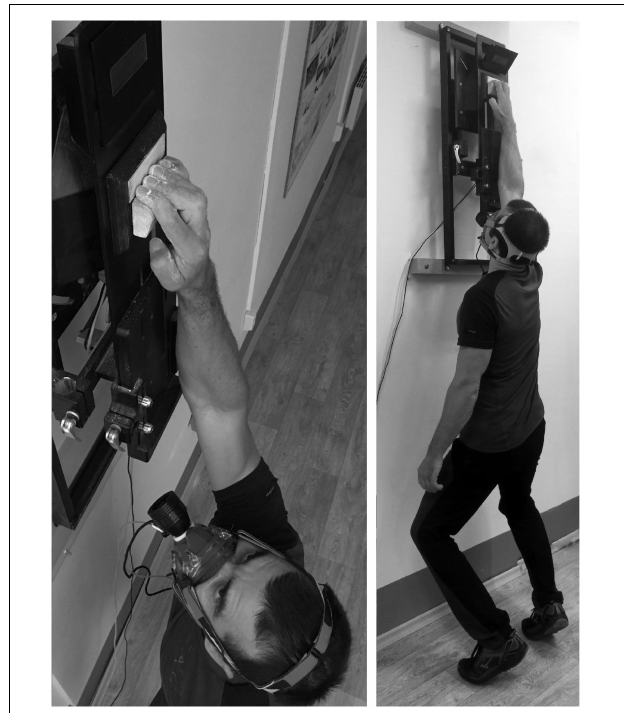
FIGURE 1 | Climber’s position during exercise